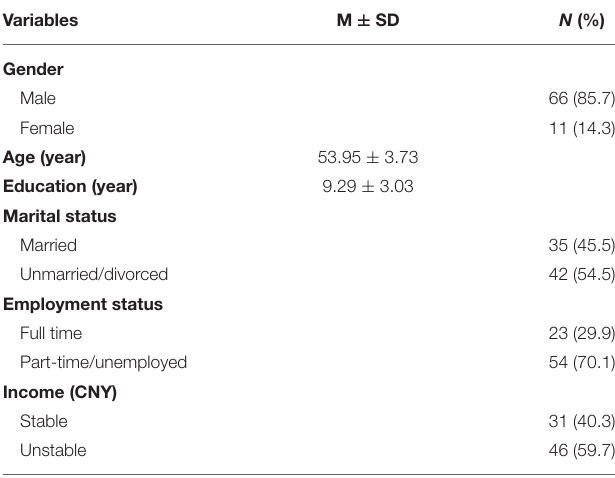
TABLE 1 | Demographic information of the subjects with substance use disorders ( N = 77).